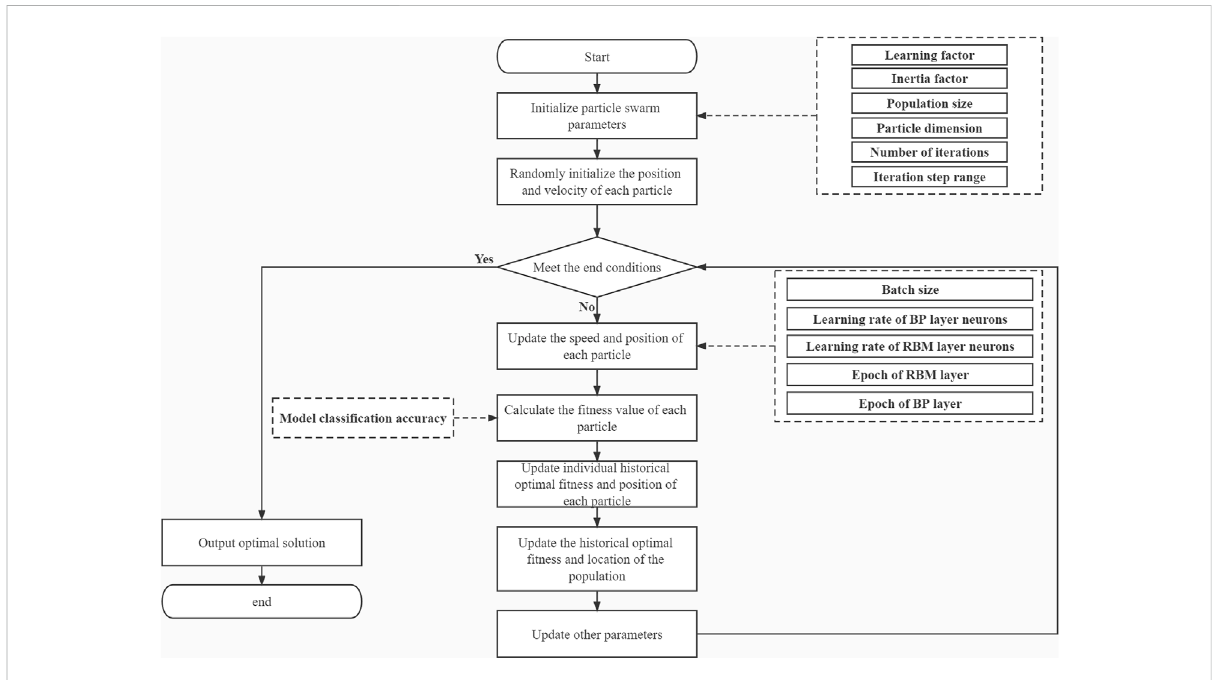
FIGURE 4 Particle swarm optimization algorithm fl ow